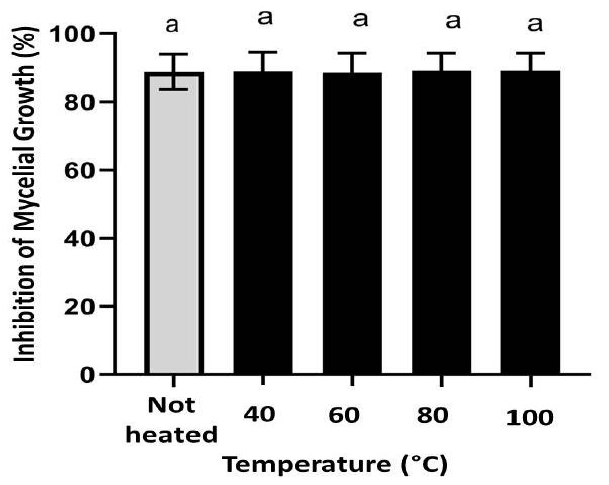
Figure 5. Effect of heating on the antifungal activity of CH@CuO NPs at 100 mg/L as representative conc.) against B. cinerea growth. Bars with the same letters are not statistically significant based on the least significant difference (LSD) test (p < 0.01).